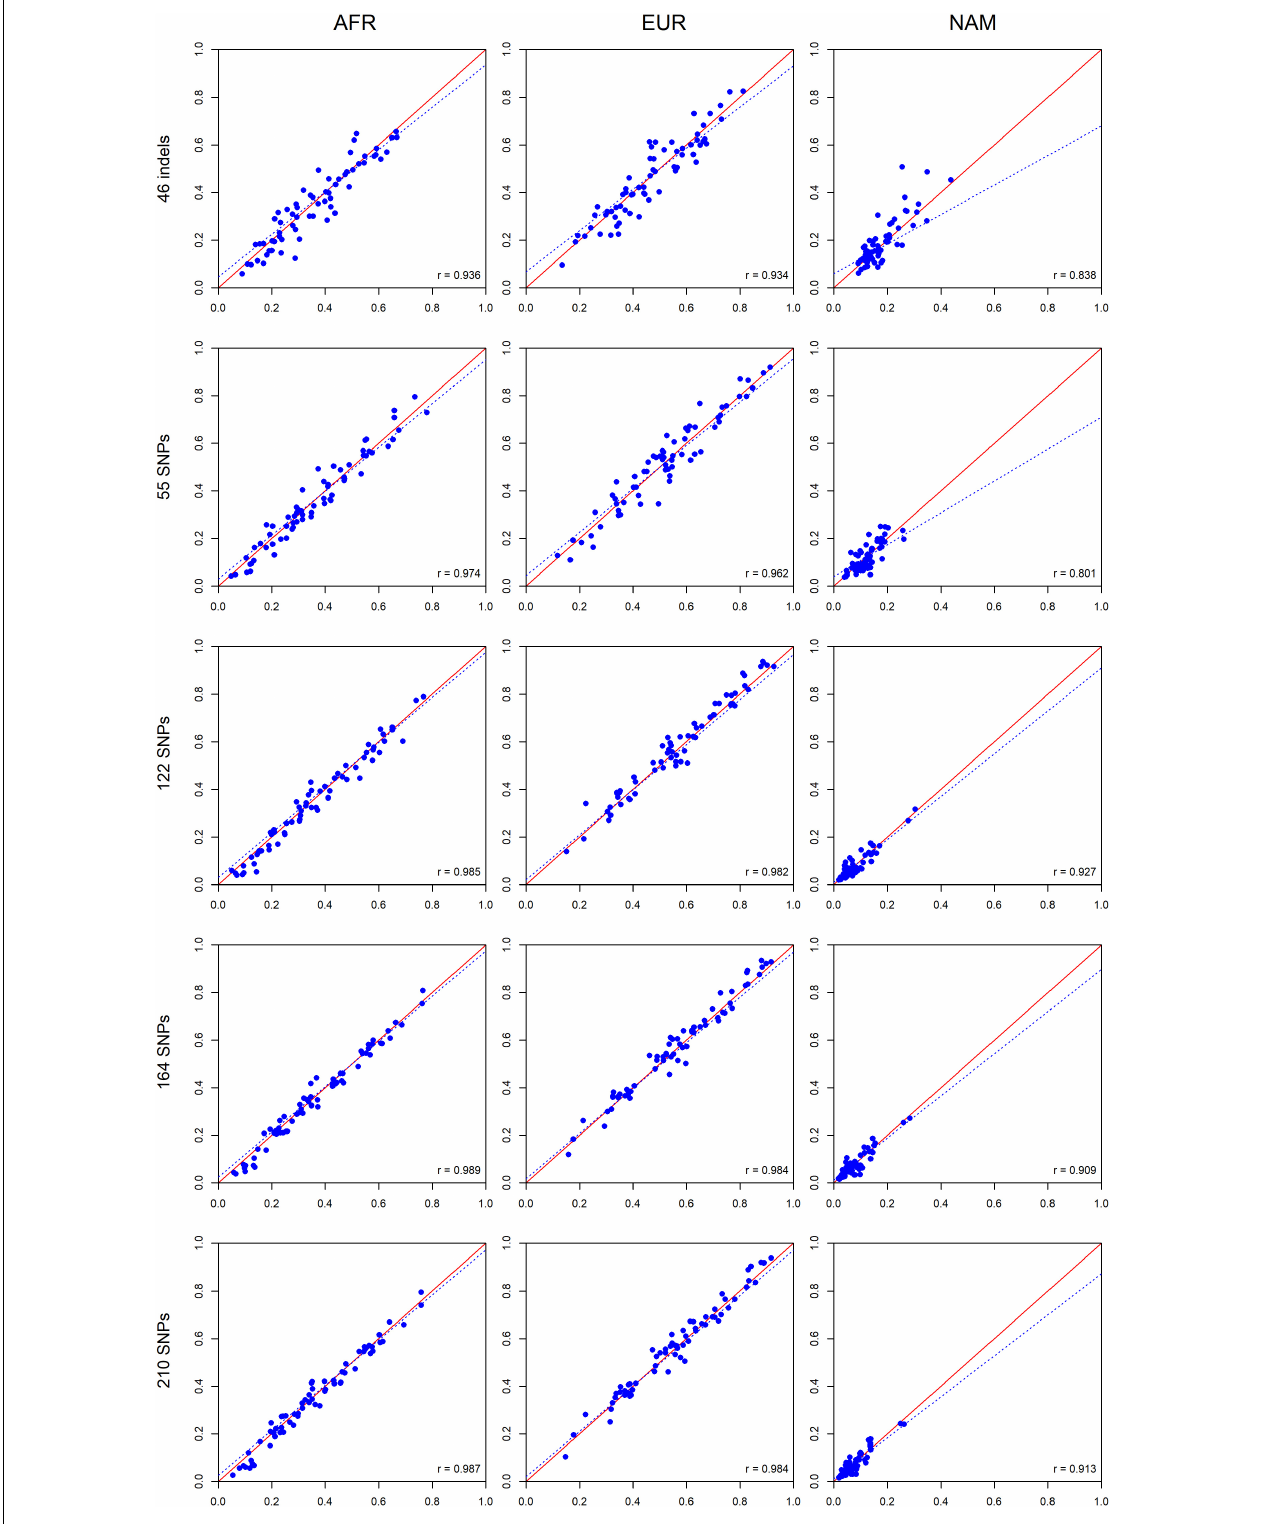
FIGURE 10 | Pairwise comparisons between the average ancestry estimates of the parents and the average estimates of their offsprings based on five AIM sets. The respective r -values are indicated in the figures, and the tendency line is represented as a blue dashed line. The red solid line indicates the perfect agreement between two AIM